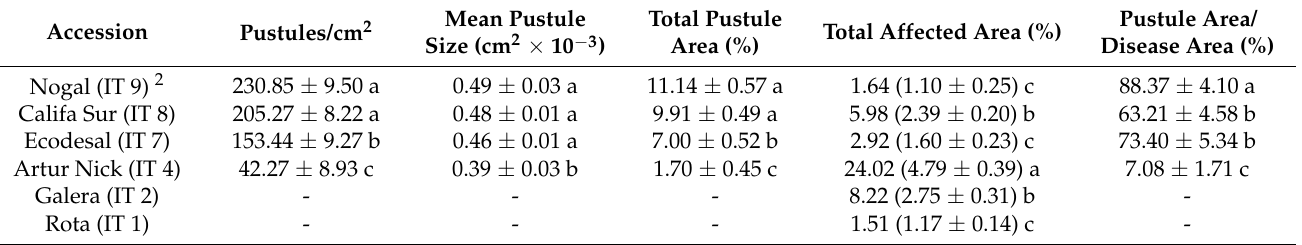
Table 1. Macroscopic image analysis of P. striiformis infection in six selected bread wheat accessions 1